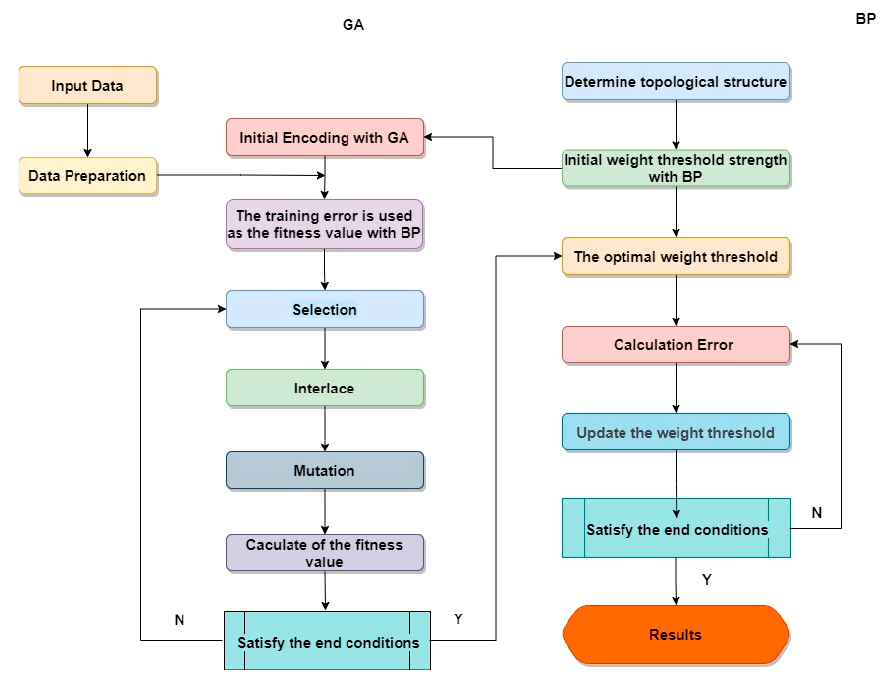
Figure 1. The algorithm structure of GA-BP neural network. Where the BP neural network is composed of two parts: One is the part of the BP neural network structure determination, namely to determine the results of the BP neural network, and thereby the length of GA individuals, according to the number of input and output parameters of the fitting function; the other is the part of the BP neural network parameter fitting, which is responsible for fitting the neural network’s input and output parameters, determining the nonlinear relations between parameters, and predicting the function output after network training. The GA optimization component uses the weights and thresholds of the genetic optimization algorithm of the BP neural network. Each individual in the population comprises all weights and thresholds of a network. Individuals’ fitness is calculated via the fitness function, in order for the genetic algorithm to find the individual with the optimal fitness value through selection, crossover, and mutation operations,